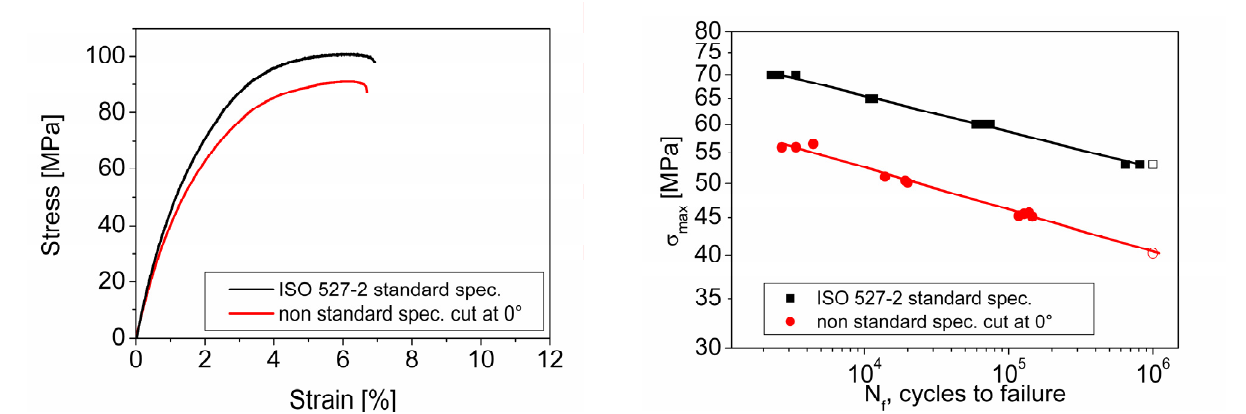
Figura 2: Resistenza statica (a) e a fatica (b) in provini standard e ricavati da lastra iniettata di testa [2].